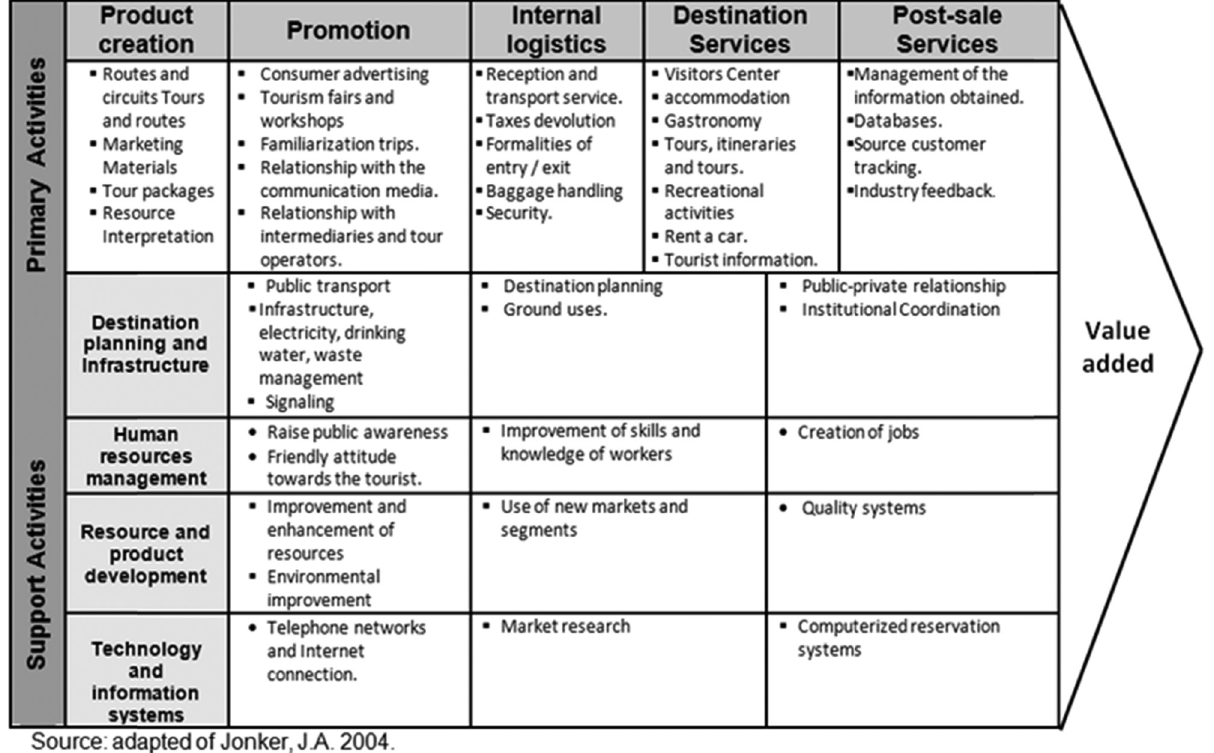
Figure 1: The value chain of a tourist destination. Source: adapted from Jonker ( 2004 ) .